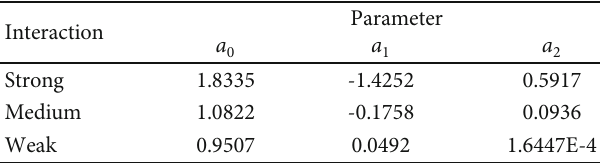
Table 1: Fluid viscosity data for di ff erent fl uid-bearing surface interactions [24].